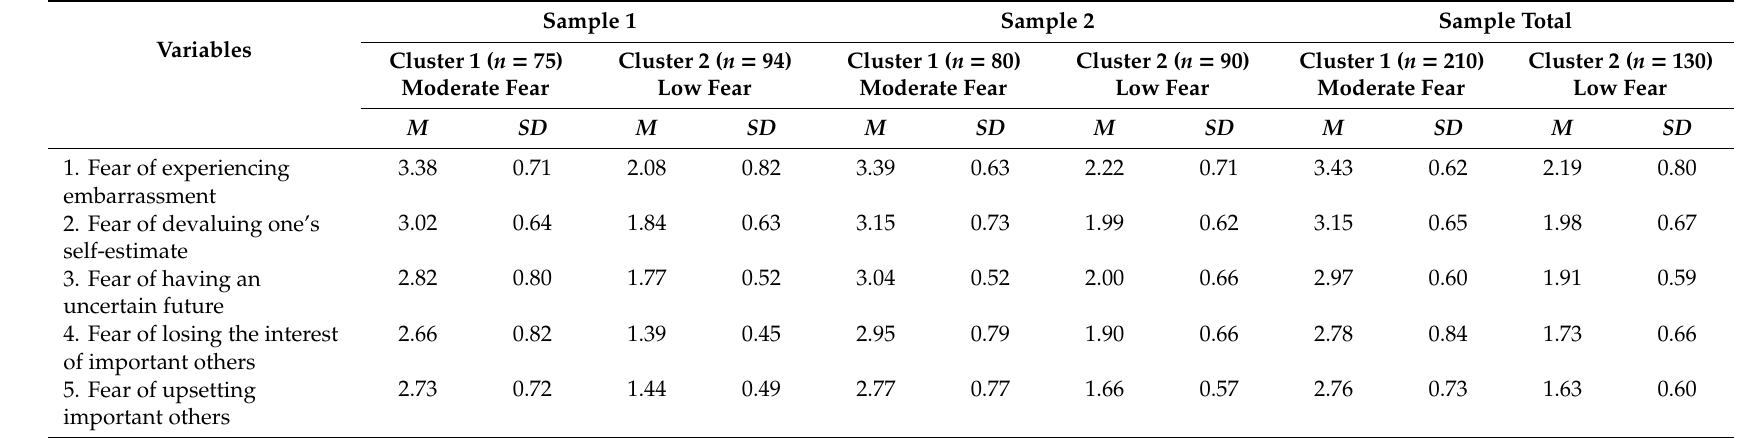
Table 2. Standardized values, means and standard deviations of the variables in each cluster for Samples 1 and 2 and overall sample.